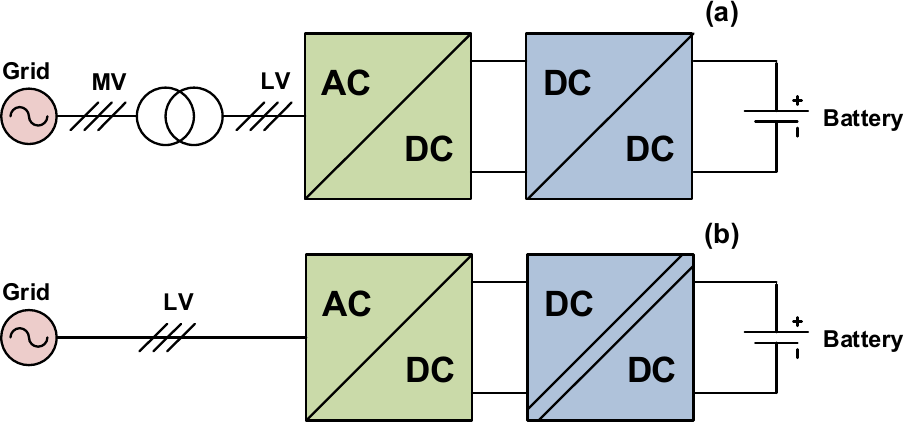
Figure 4. Structural scheme of the ultra-fast charging systems: ( a ) ultra-fast charging station with a non-isolated DC/DC converter; ( b ) ultra-fast charging station with an isolated DC/DC converter.